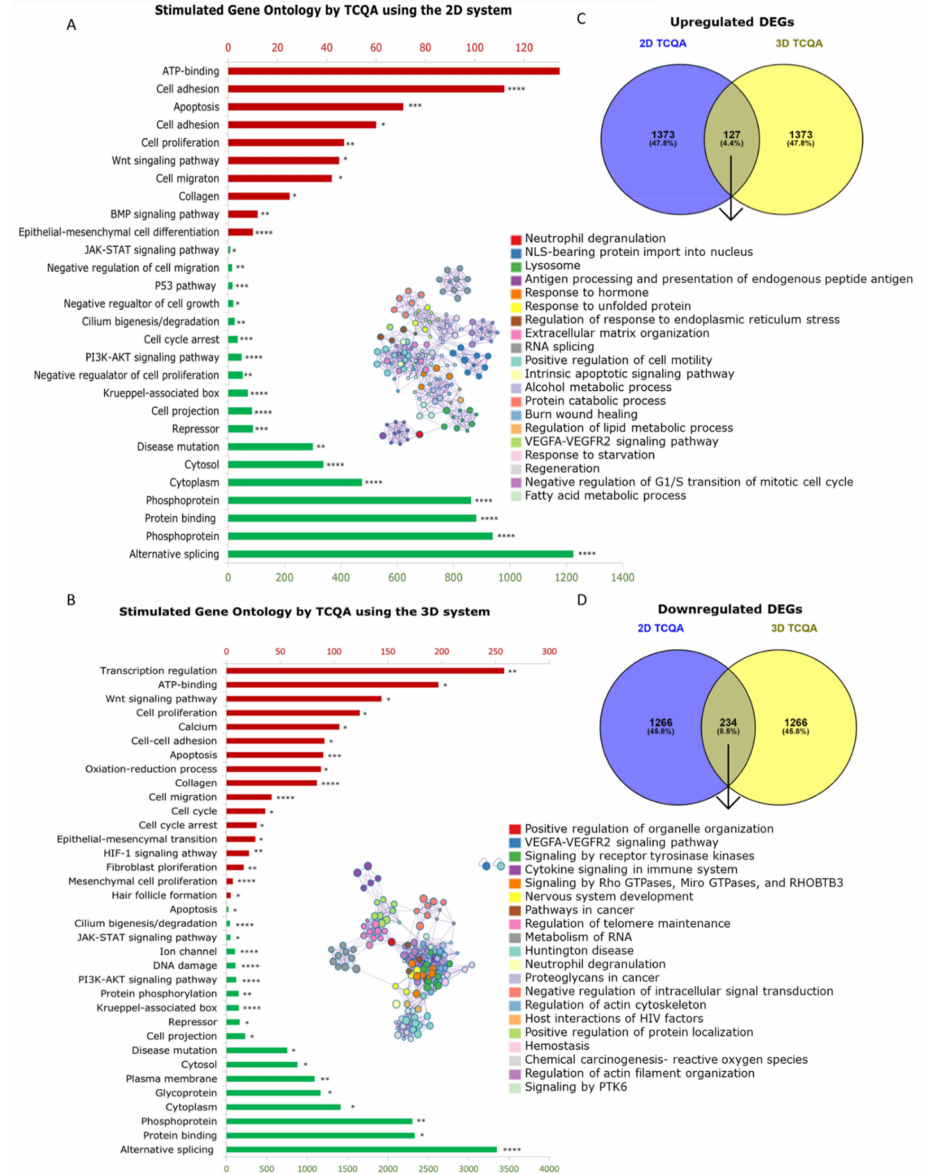
Figure 4. The significantly enriched DEG biological processes stimulated by TCQA-treated 2D- and 3D-cultured HFDPCs. ( A ) The top significantly enriched gene ontologies (GO) by the upregulated and downregulated DEGs in 2D-cultured HFDPCs treated with TCQA. ( B ) The top significantly enriched gene ontologies (GO) in the upregulated and downregulated DEGs of 3D-cultured HFDPCs treated with TCQA. The red bar plots represent the upregulated DEGs, while the green bar plots represent the downregulated DEGs. ( C ) Venn diagram showing the upregulated genes of TCQA- treated 2D- and 3D-cultured HFDPCs and the number of overlapping genes. The arrow points to the biological process obtained from the overlapping genes visualized using a cluster generated from Panther. ( D ) Venn diagram showing the downregulated genes of TCQA-treated 2D- and 3D-cultured HFDPCs and the number of overlapping genes. The arrow points to the biological process obtained from the overlapping genes visualized using a cluster generated from Panther Classification system (www.pantherdb.org). An ANOVA was used to assess the level of significance between the groups. * Statistically significant ( p -value ≤ 0.05), ** statistically significant ( p -value ≤ 0.01), *** statistically significant ( p -value ≤ 0.001), **** statistically significant ( p -value ≤ 0.0001). For GO analysis with DAVID, Modified Fisher Exact p -value was